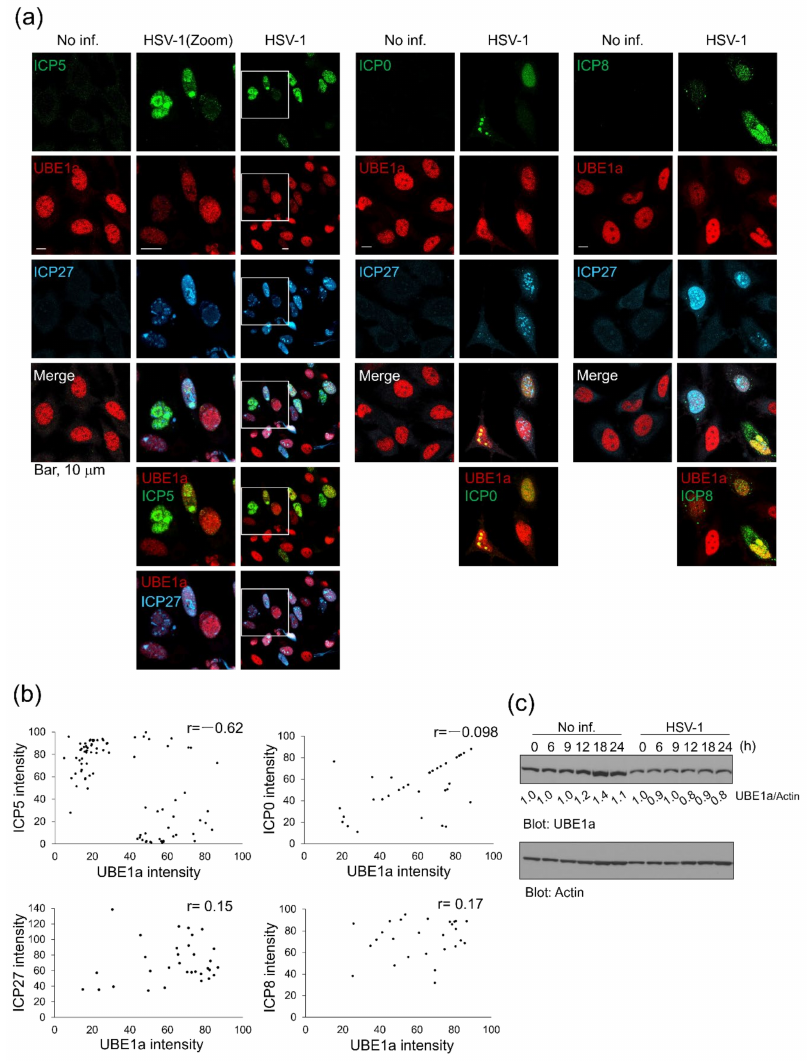
Figure 2. The expression level of UBE1a was a negatively correlated with ICP5 expression. ( a ) HeLa cells were infected with HSV-1 at an MOI of 2 for 60 min and fixed at 18 hpi (hours post-infection). The localization of UBE1a with ICP5 (late (L) gene product), ICP0 (IE gene product), ICP27 (IE gene product), and ICP8 (early (E) gene product) was observed by confocal microscopy. ( b ) The correlations of fluorescence intensities between UBE1a and the nuclear-localizing virus protein, ICP5 ( n = 97), ICP0 ( n = 43), ICP27 ( n = 31), and ICP8 ( n = 27), were plotted. ( c ) The amount of UBE1a expression did not change either no infection or HSV-1 infected cells. HeLa cells were infected with or without HSV-1 and harvested at 0, 6, 9, 12, 18, and 24 h. Cell lysates were analyzed for UBE1a and actin antibodies. The band intensities of virus proteins were calculated by using ImageJ software and normalized to actin. The values for UBE1a / actin are presented at the bottom of each lane, and the values for non-infected cells are presented as